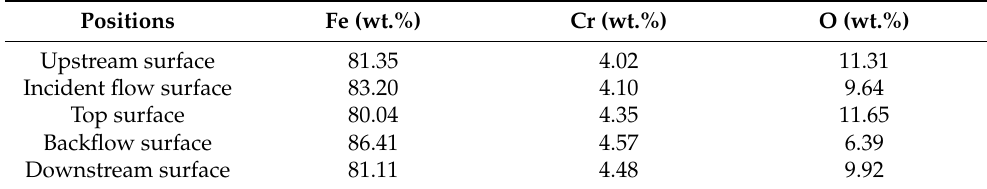
Figure 9. SEM morphologies and elemental X-ray mapping of ( a ) the upstream surface, ( b ) incident flow surface, ( c ) top surface, ( d ) backflow surface, and ( e ) downstream surface of the WRH with corrosion products after 6 h flow corrosion. Table 2. The EDS analysis of the areas shown in Figure